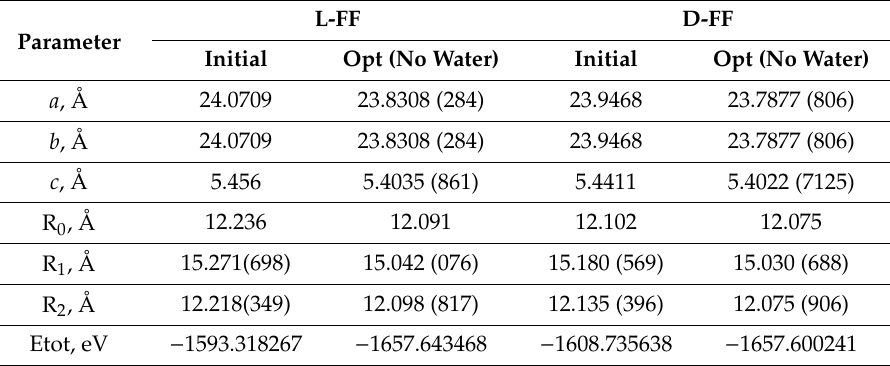
Table 2. Parameters of inner hydrophilic cavity of L-FF and D-FF